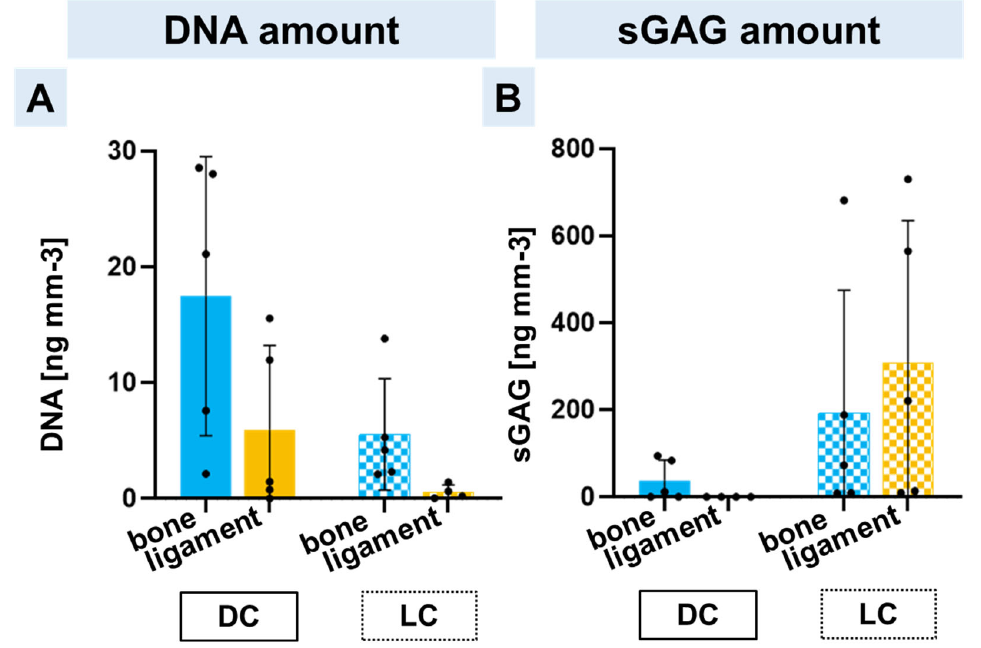
Figure 5. Calculation of the DNA ( A ) and sGAG ( B ) amount of each scaffold zone after direct (DC) or long pre ‐ cultivation (LC). The DNA and sGAG amounts were calculated per cubic millimeter scaffold in the bone zone with hMSC spheroids (blue) and in the ligament zone with lACL spheroids (orange). Five independent experiments analyzed with ROUT (1%) outlier test and one ‐ way ANOVA showed no significant differences.